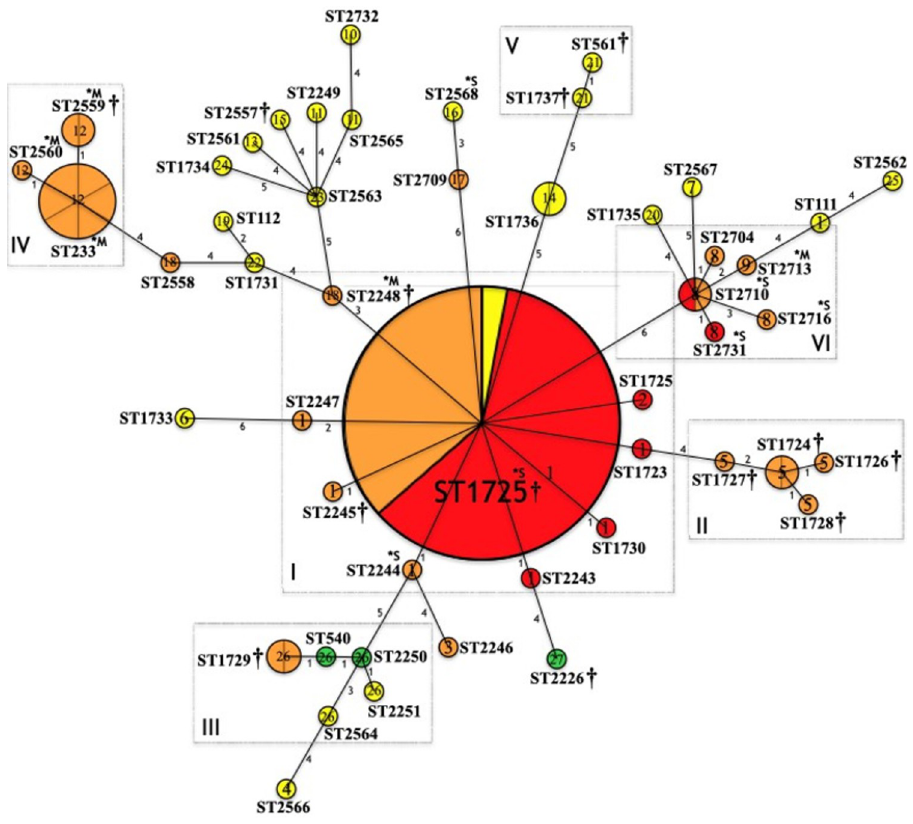
Fig 2. Phylogenetic network based on the MLST genotyping of the P . aeruginosa strains (ST/haplotypes/ resistance). Relationship between the mexR-nalC-nalD haplotypes, the STs and, the susceptibility profiles are shown. P . aeruginosa isolates (n = 91, 48 STs, 27 mexR-nalC-nalD haplotypes). Circles represent sequence types (STs); Circumference is based on ST frequency; Two or more strains with the same ST, including ST1725 are depicted as fractions in each circle (n = 34 strains); Lines connect locus variants; Numbers indicate the number of locus variants among the connected STs. Clonal complexes (CC) formed are highlighted in rectangles and described as I, II, III, IV, V and, VI. STs not grouped into a CC are considered singletons ( > 3 locus variants with other STs). Number inside the circles (1–27) corresponds with the mexR-nalC-nalD haplotype and are colored differently. †: Fatal patient outcome. Susceptibility profiles: S (green), sensitive; MDR (yellow), multidrug resistant; XDR (orange), extensively drug resistant; PDR (red), pan drug resistant. � S: Serine carbapenemase; M � : Metallo- β